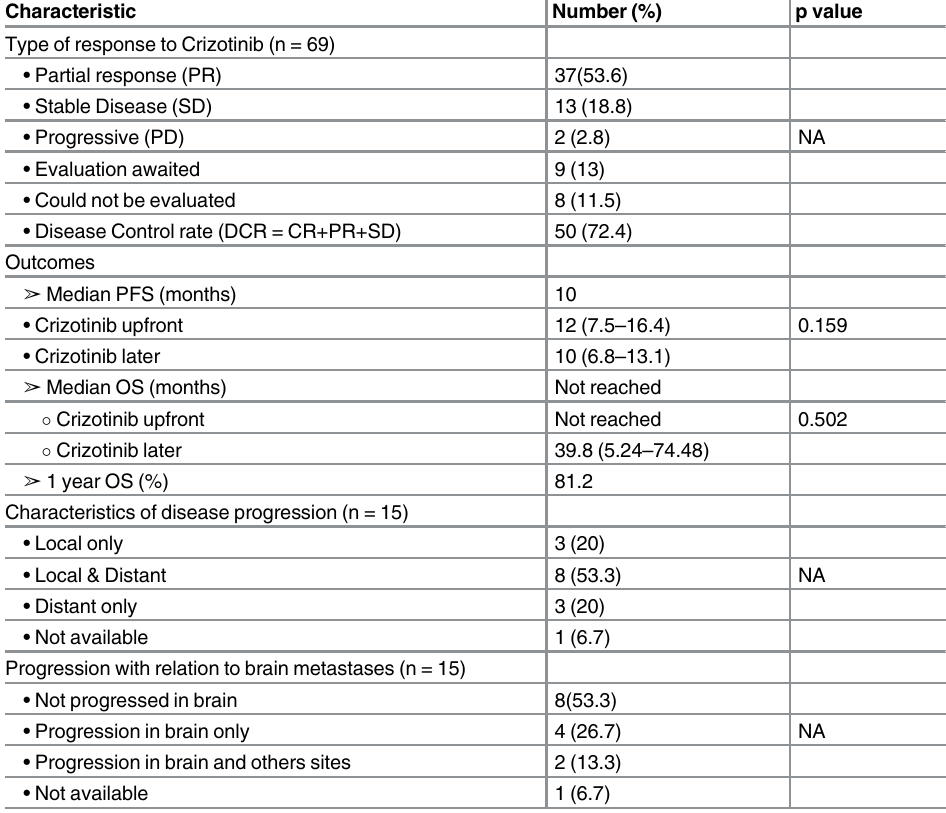
Table 4. Response rates, Survival and pattern of progression on